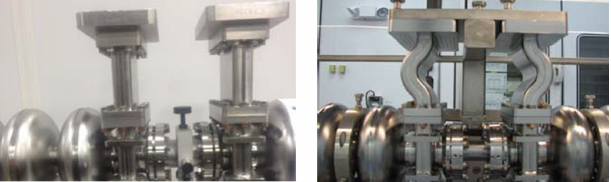
FIG. 3. Close-up picture of the FPC waveguide section for original C20 cavities (left) and after the refurbishment using doglegs (right) as installed in C50 and C75 cryomodules.